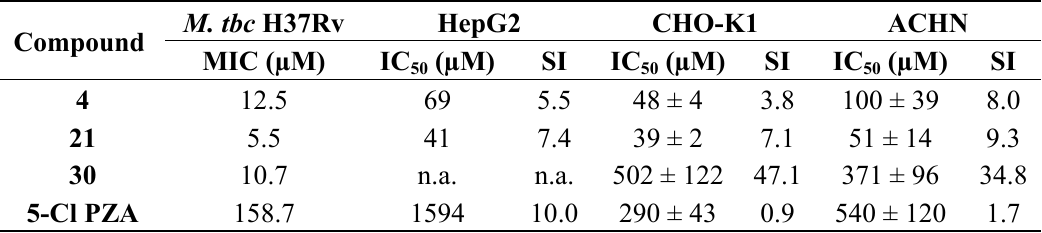
Values are expressed as the IC